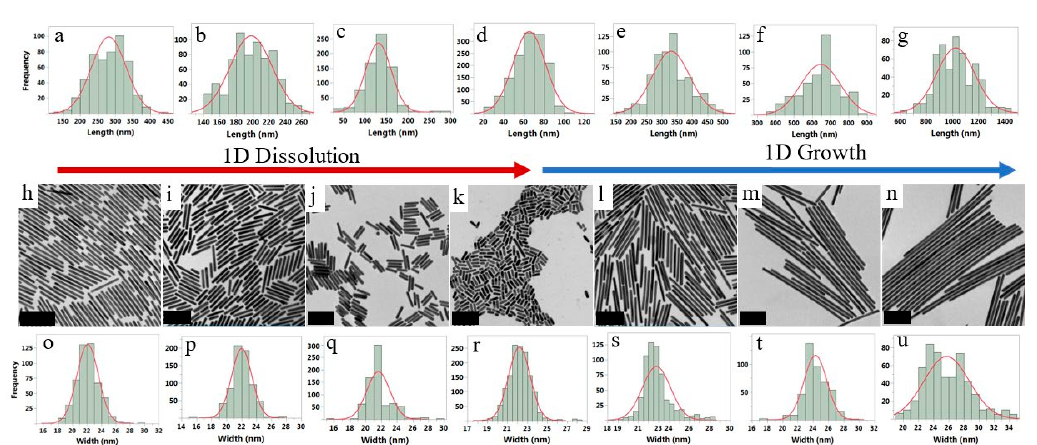
Figure 3. The length and width distribution of AuNRs during the dissolution and growth process and the corresponding transmission electron microscopy (TEM) images. Length distribution ( a – g ), width distribution ( o – u ) and corresponding TEM images ( h – n ) during the growth and dissolution processes. Reproduced with permission from [59]. Copyright ACS Nano, 2019.